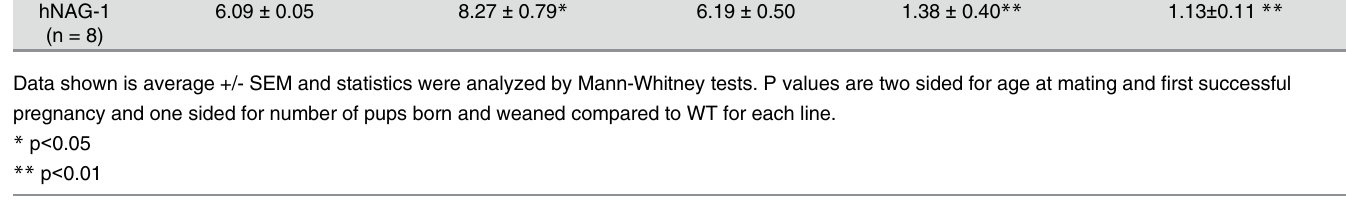
Table 1. Continuous breeding study of hNAG-1 transgenic females paired with proven male for 4 litters. Genotype